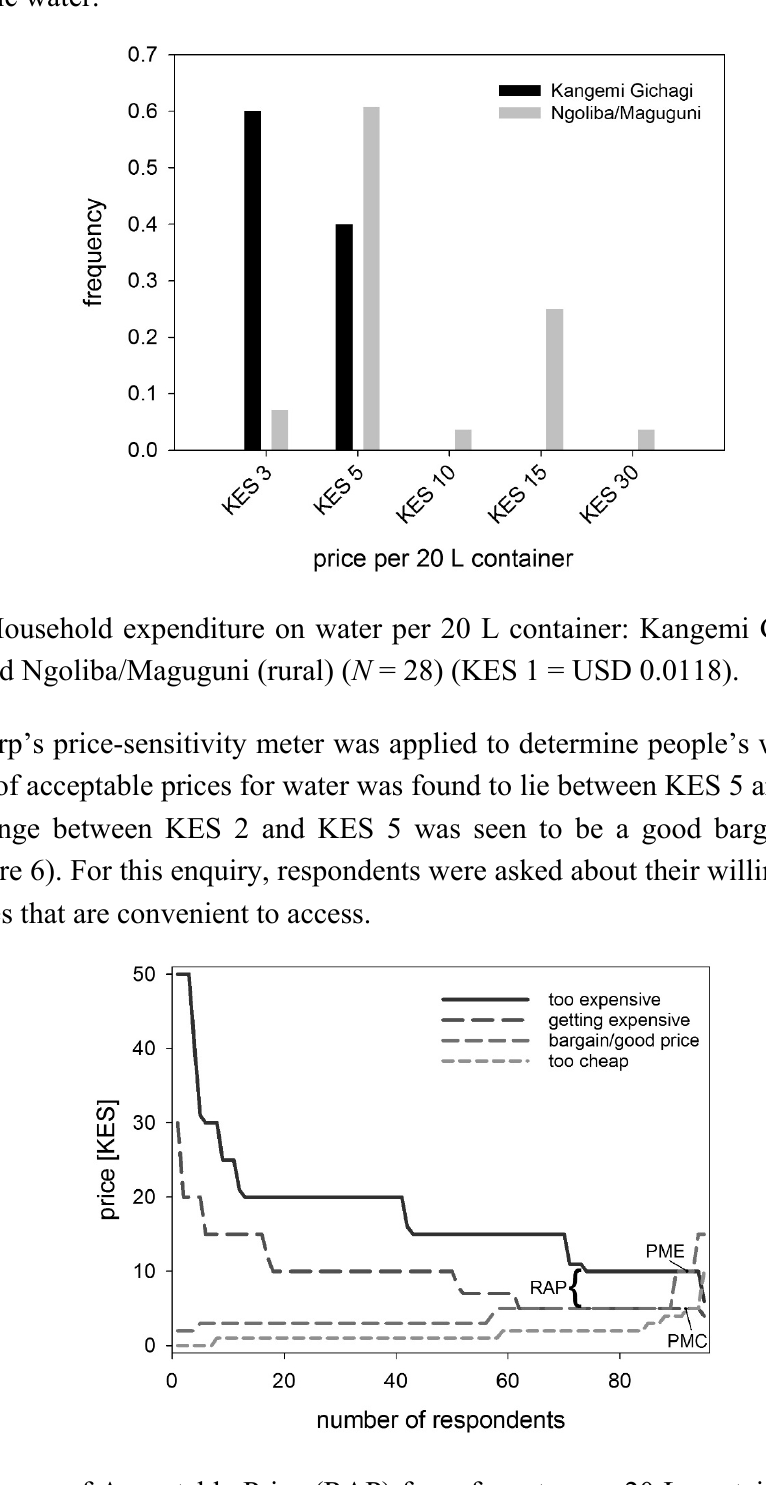
Figure 6. Range of Acceptable Price (RAP) for safe water per 20 L container in Kangemi Gichagi and Ngoliba/Maguguni, N = 96. PME = point of marginal expensiveness, PMC = point of marginal cheapness (KES 1 = USD